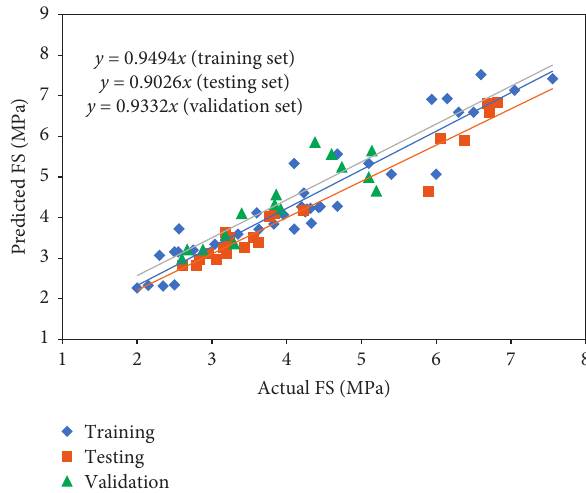
Figure 6: Comparison of actual and predicted